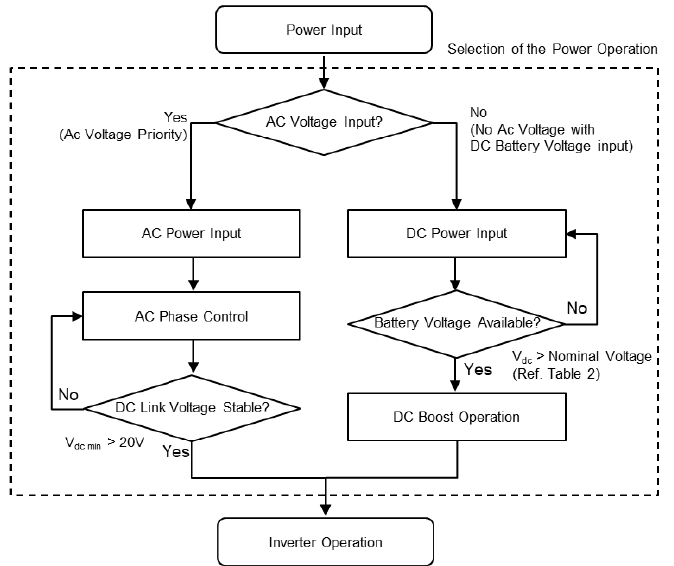
Figure 5. Flowchart showing the motor drive chart for AC and DC power input.